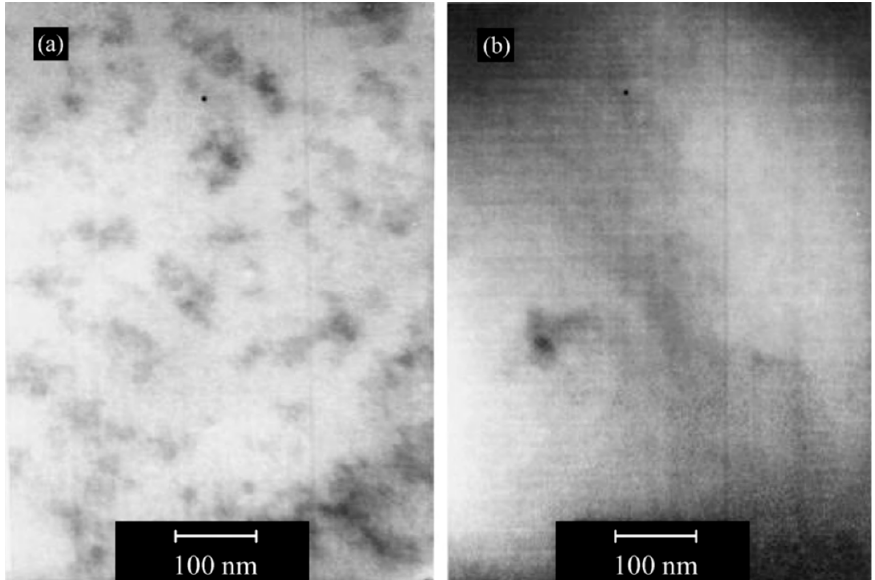
Figure 6. TEM micrographs of epoxy–SiO 2 hybrids with 10 wt % SiO 2 : ( a ) Hybrid films prepared without SCAs; and ( b ) hybrid films prepared with APTES. Reproduced with permission from Nazir et al. Progress in Organic Coatings ; published by Elsevier B.V., 2010.